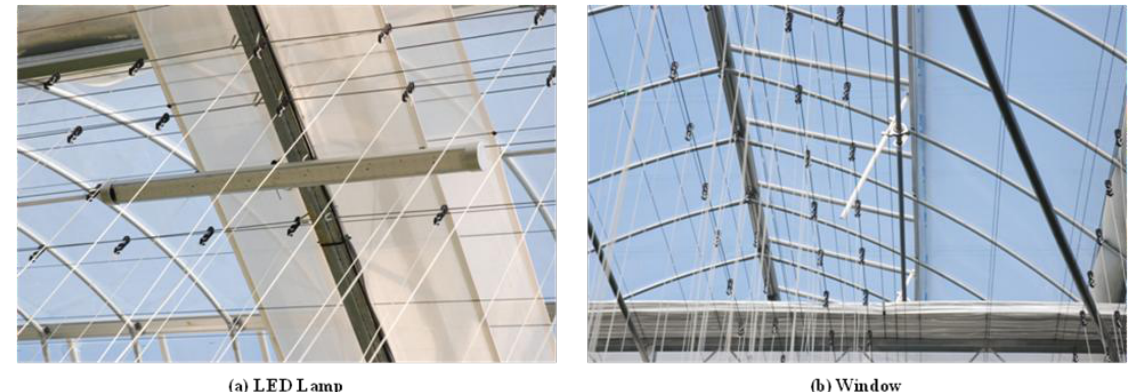
Figure 5. Environment control facilities and